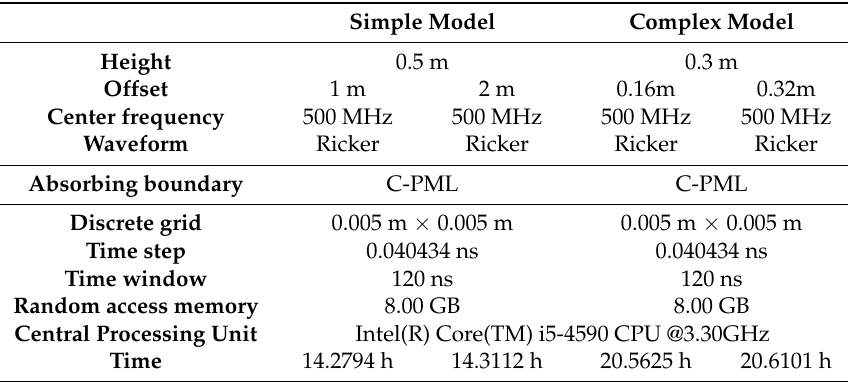
Table 2. Simulation parametersof the experiment models.